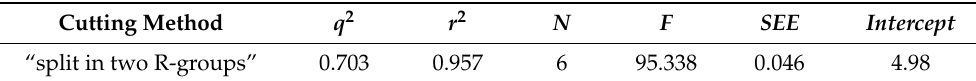
Table 1. Statistical Results of the Topomer CoMFA.